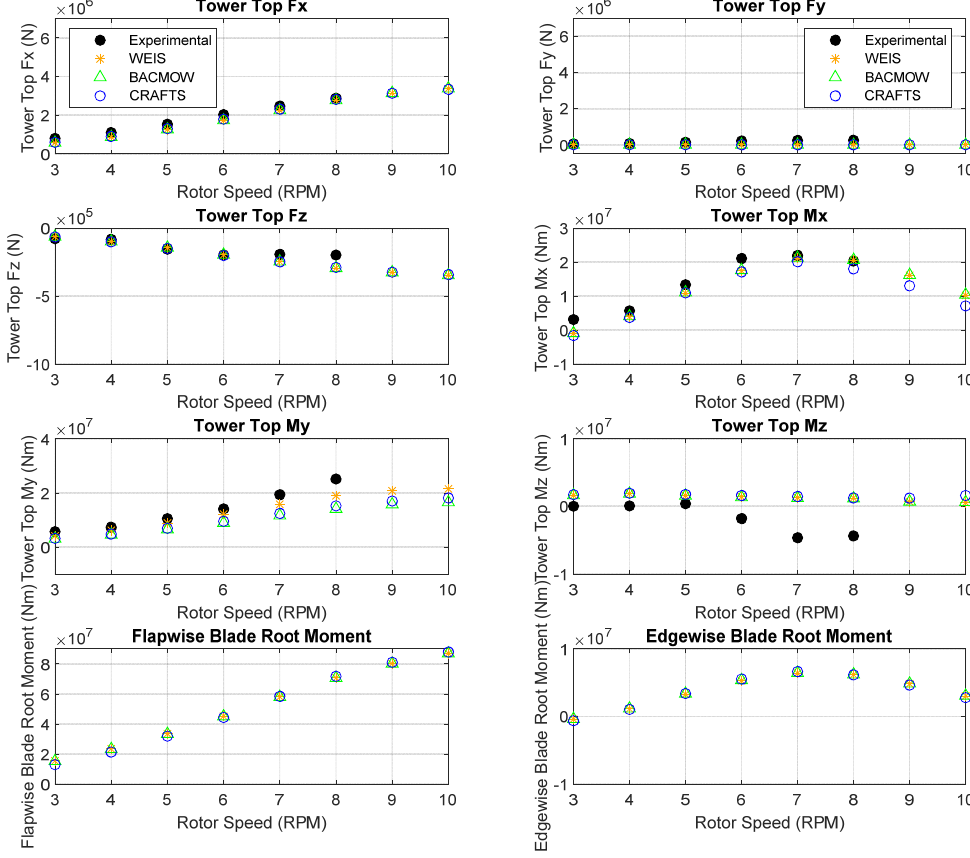
Figure 5. LC 1.1 tower top forces and moments, blade root bending moments. The results for LC 1.2, which was similar to LC 1.1, but with a pitch of 10 ◦ ,